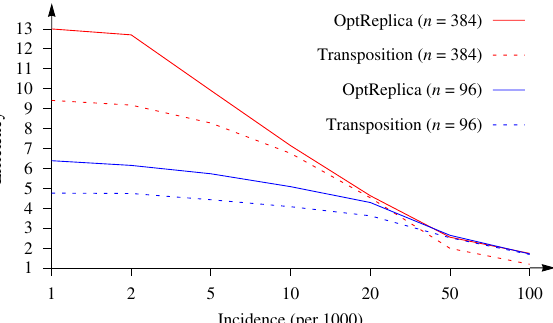
Figure 5. Efficiency of OptReplica with the optimal pools sizes versus the transposition based replication.